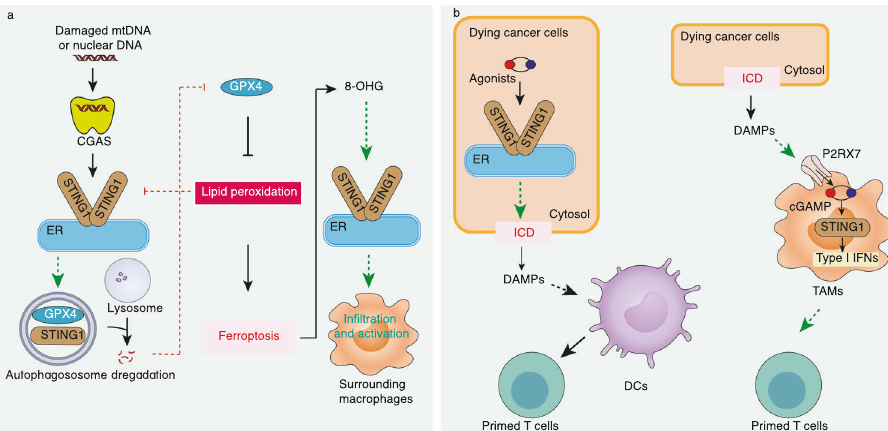
Fig. 5 STING1 in ferroptosis and ICD. a mtDNA and nDNA activate STING1-dependent autophagy, leading to GPX4 degradation and subsequent lipid peroxidation-mediated ferroptosis, whereas lipid peroxidation negatively regulates STING1 through carbonylation. Ferroptotic damage also activates STING1 in surrounding macrophages by releasing oxidative DNA damage products, such as 8-OHG. b STING1 engages in ICD in two ways: inducing DC-dependent T-cell priming or TAM-mediated T-cell priming. 8-OHG 8-hydroxy-2 ′ - deoxyguanosine, cGAMP cyclic GMP-AMP, CGAS cyclic GMP-AMP synthase, DAMPs damage-associated molecular patterns, DCs dendritic cells, ER endoplasmic reticulum, GPX4 glutathione peroxidase 4, ICD immunogenic cell death, P2RX7 purinergic receptor P2X 7, STING1 stimulator of interferon response cGAMP interactor 1, TAMs tumor-associated